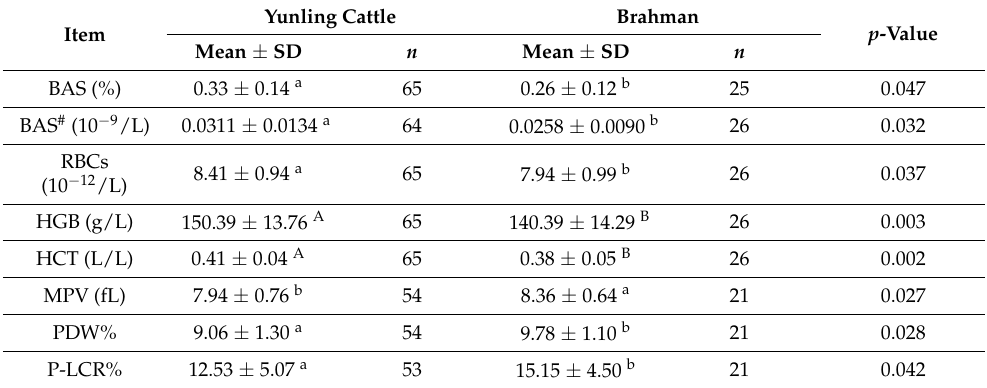
Table 2. Comparisons of hematology indicators between Brahman and Yunling